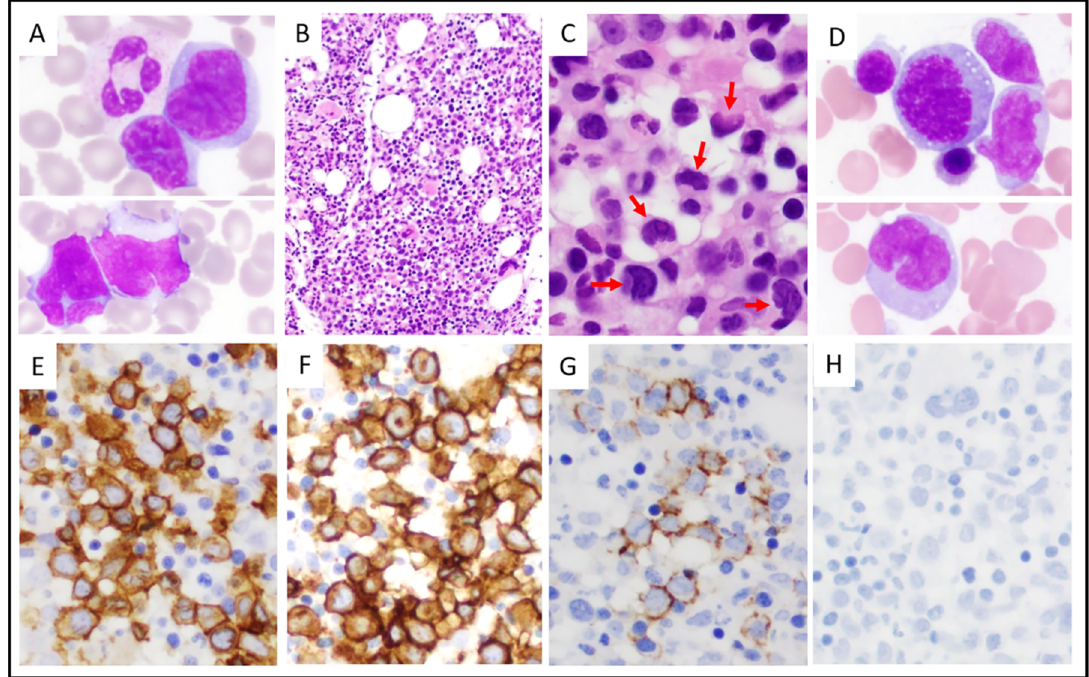
Figure 1. A representative case of leukemic ALK-negative ALCL (case 9). ( A ), The peripheral blood smear showed circu- lating lymphoma cells with large, pleomorphic nuclei, condensed chromatin, and small to moderate amounts of cytoplasm. ( B – C ), The bone marrow core biopsy specimen revealed hypercellular bone marrow involved by lymphoma cells in an interstitial pattern (indicated by arrows). Some of the lymphoma cells had kidney-shaped nuclei (hallmark cells). ( D ), Bone marrow aspirate smears showed lymphoma cells, similar to those in the peripheral blood smear. ( E – H ), The lymphoma cells were positive for CD3 ( E ), CD30 ( F ), EMA (( G ), small subset), and were negative for ALK ( H ). ( A , D ), Wright-Giemsa stain, × 1000. ( B ), hematoxylin-eosin stain, × 100. ( C ), hematoxylin-eosin stain, × 400. ( E – H ), immunohistochemistry, × 400.